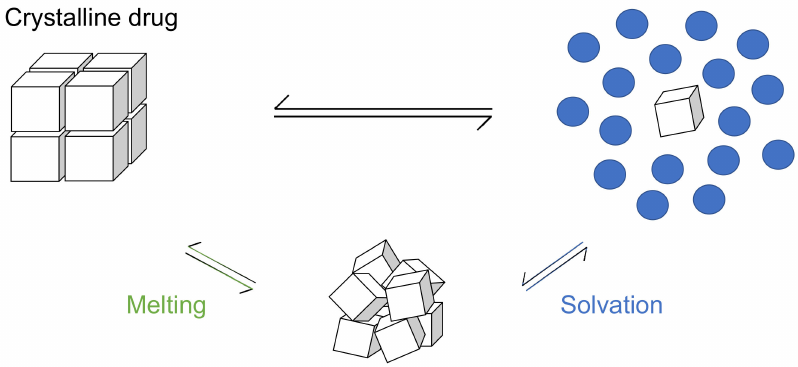
Figure 1. Thermodynamic scheme of crystalline drug